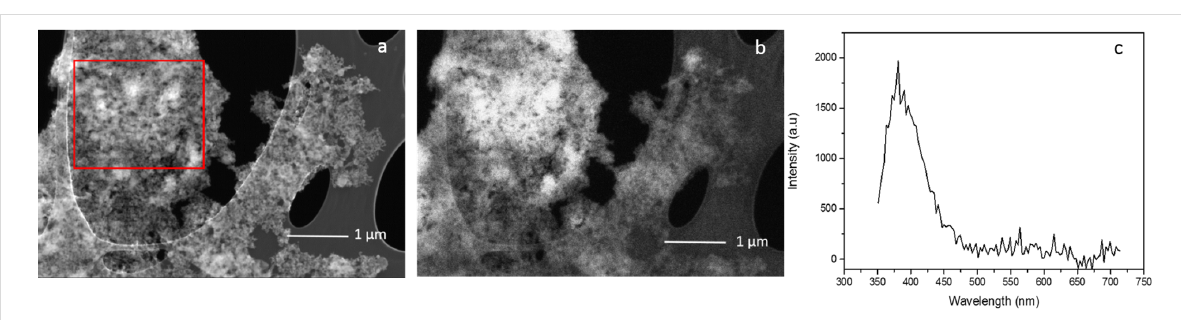
Figure 2: Sample A (SiO 2 +Ge, 33 mJ/pulse); a) SEM image of the zone indicated as square 2 in Figure 1a; b) CL panchromatic map of the same region; c) CL spectrum recorded in the zone marked by the red square in panel